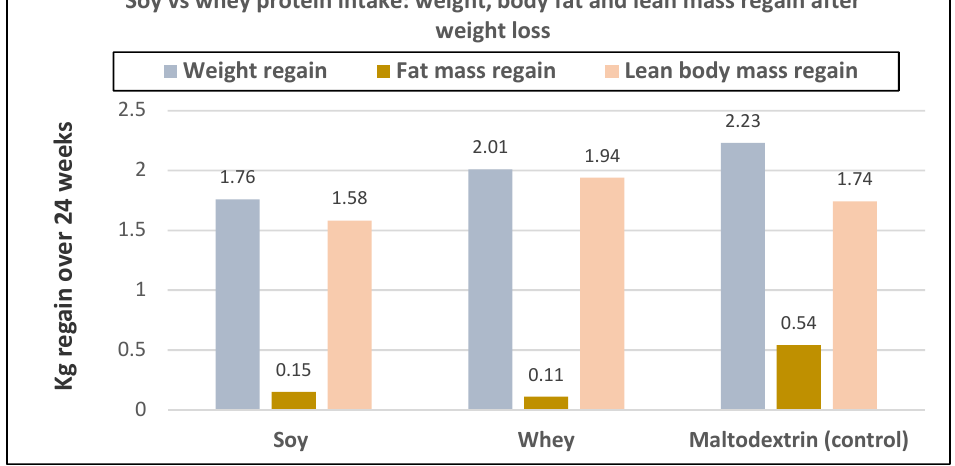
Figure 22. Double-blinded randomized controlled trial on the effects of type of protein (45 g/day) vs. carbohydrate control and weight regain after weight loss; included 171 adults (78% women) over 24 weeks ( p = 0.50 to 0.96) [63].